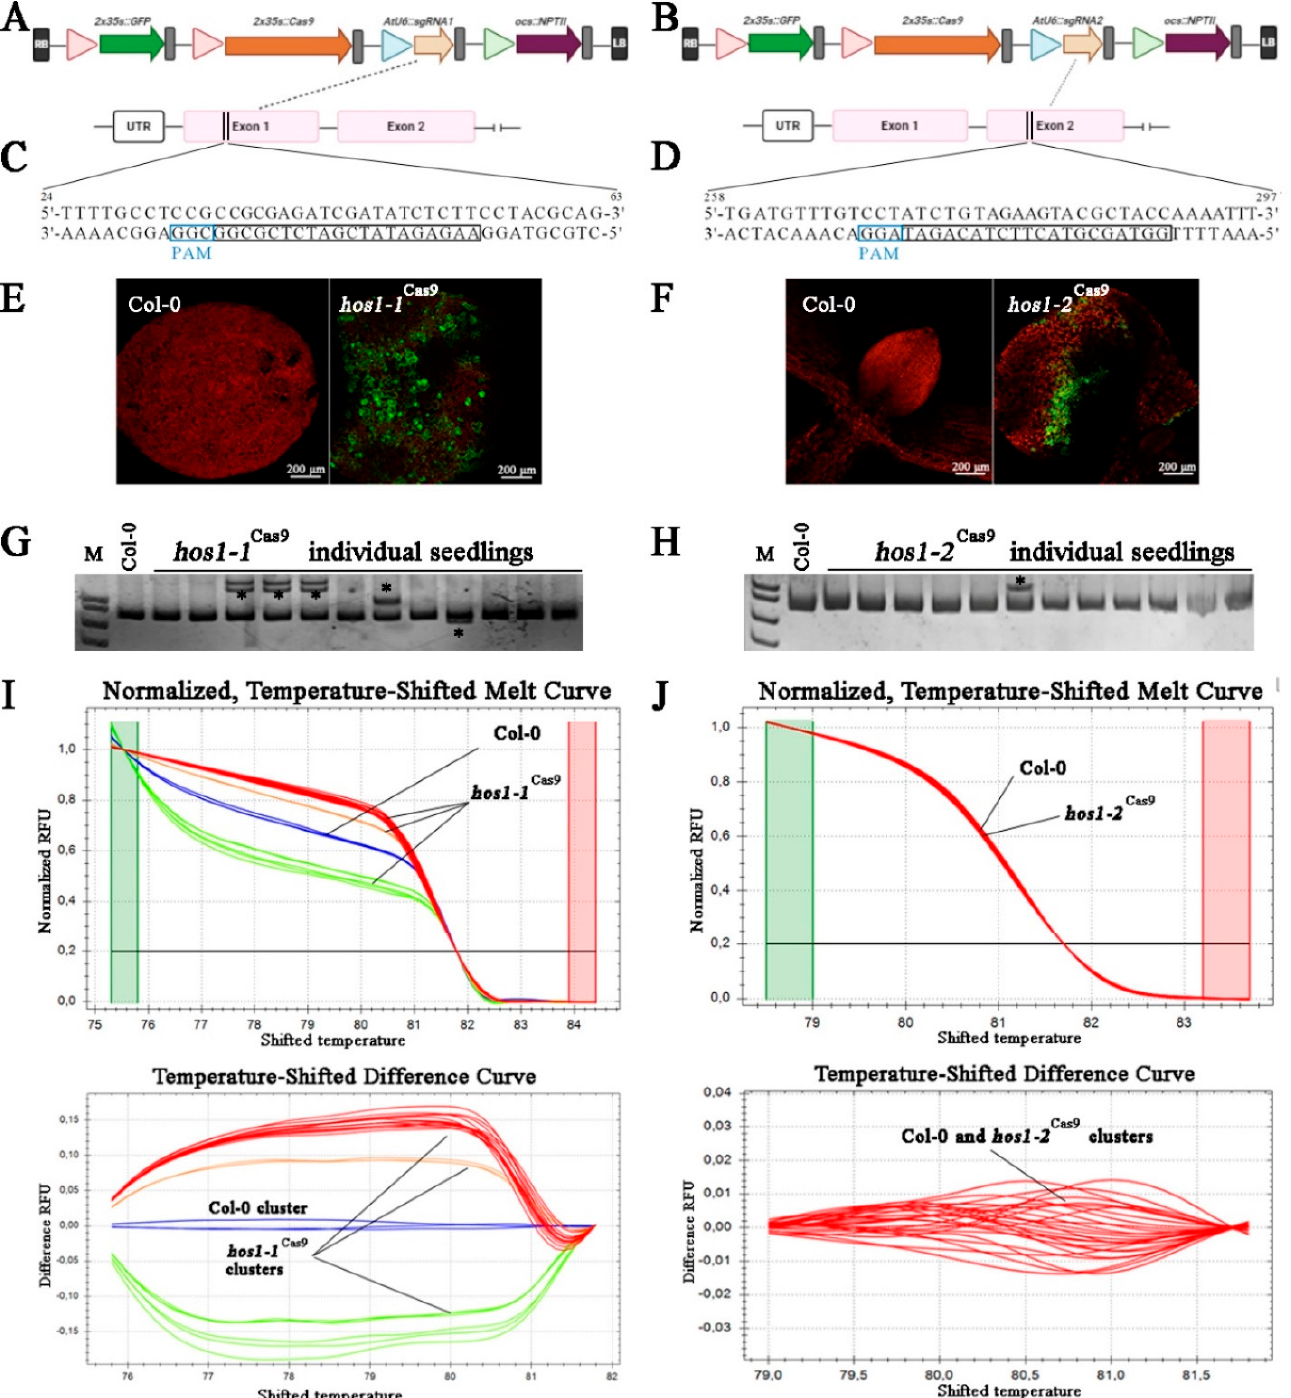
Figure 1. Schematic illustration of the CRISPR/Cas9 vectors, gRNA target sites, GFP fluorescence in transiently transformed seedlings and mutant screening. ( A , B ) The physical map of T ‐ DNA fragment of binary vectors used in this study. ( C , D ) The target sequences for mutagenesis with gRNA1 and gRNA2. The selected protospacer sequences are shown in black boxes and the protospacer adjacent motifs (PAMs) are in blue boxes. ( E , F ) Visualization of green fluorescent protein (GFP) fluorescence in A. thaliana seedlings subjected to Agrobacterium ‐ mediated transformation using vacuum infiltration. ( G , H ) Heteroduplex mobility assay (HMA) of A. thaliana seedlings transformed with the CRISPR/Cas9 using polyacrylamide gel electrophoresis (PAGE). Asterisks (*) indicate heteroduplex bands. ( I , J ) High resolution melting (HRM) analysis of amplicons corresponding to targeted HOS1 gene regions in transformed A. thaliana seedlings.